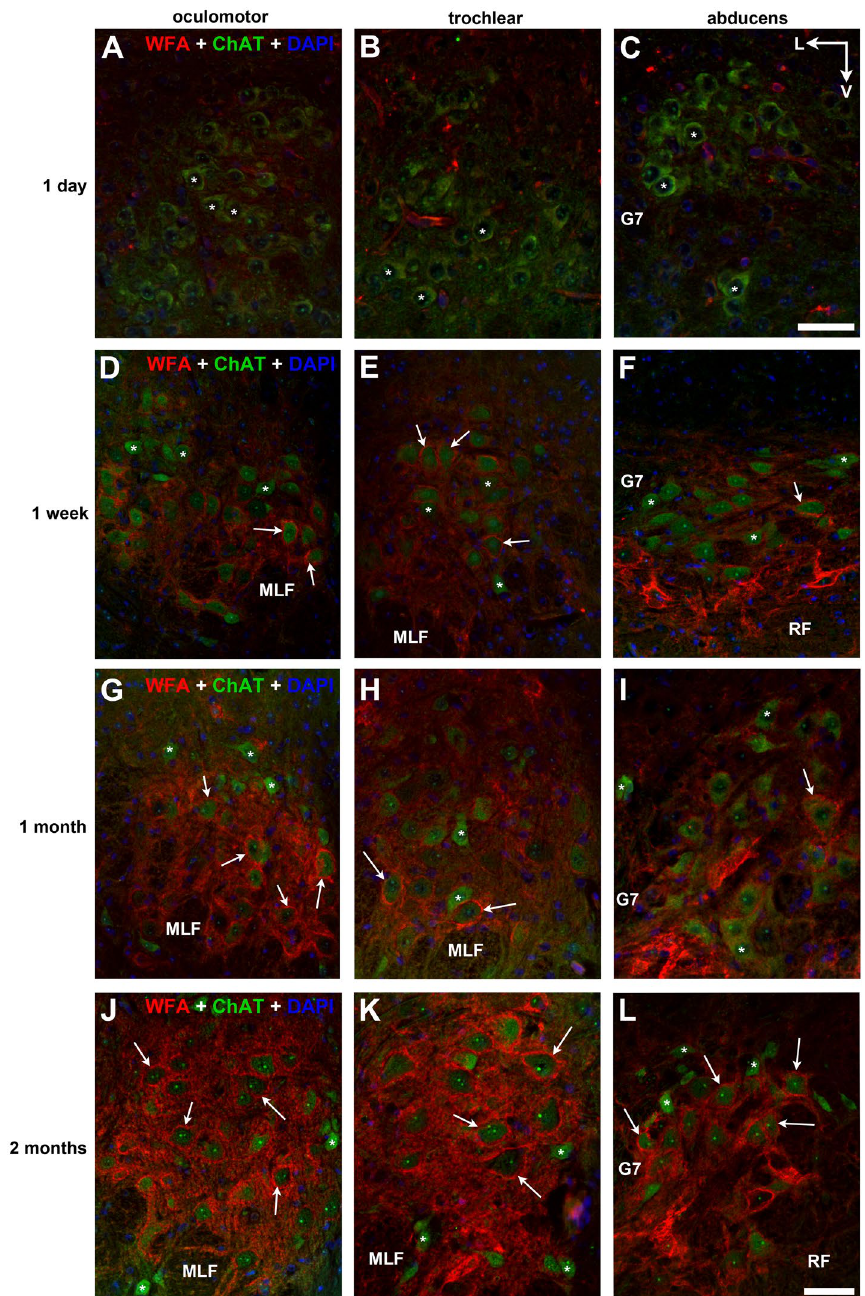
Figure 8. Development of PNNs around cholinergic motoneurons (green) in the oculomotor- ( A , D , G , J ), trochlear- ( B , E , H , K ) and abducens ( C , F , I , L ) nuclei, screened on postnatal 1st day ( A – C ), 1st week ( D – F ), 1st month ( G – I ) and 2nd month ( J – L ). PNNs form (labeled with WFA, red) from postnatal day 1, however the proportion of PNN bearing motoneurons (arrows) and histochemical reactivity of PNNs gradually rise towards adulthood. Asterisks: non-PNN bearing motoneurons. G7: facial genu. MLF: medial longitudinal fasciculus. RF: reticular formation. V: ventral. L: lateral. Scalebar: 20